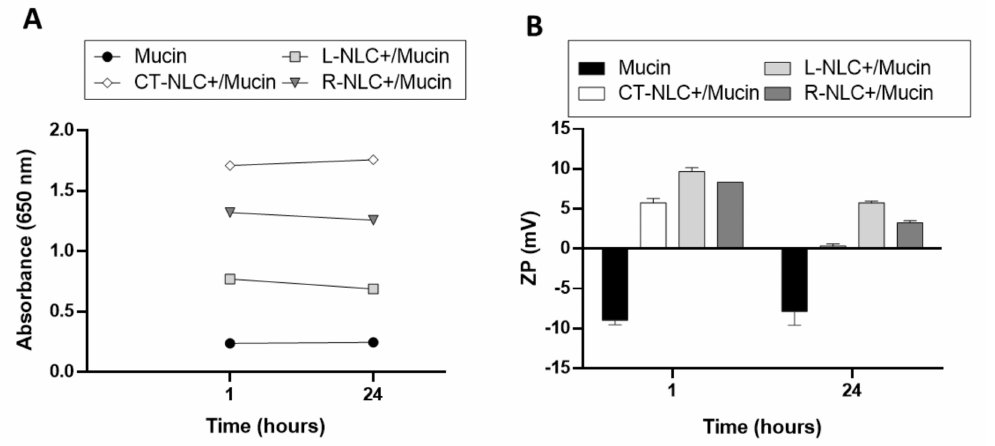
Figure 10. In vitro assessment of mucin interactions with CT-NLC+, R-NLC+, and L-NLC+ by turbidimetric assay at 650 nm ( A ) and Zeta potential (ZP) modifications ( B